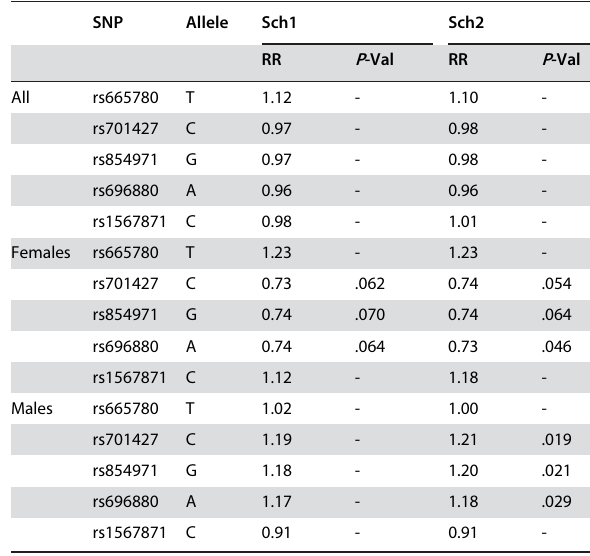
Table 3. LAMP results for individual SNPs .. ... .... ... ... .... ... ... .... ... ... .... ... ... .... ... ... .... ... ... .... .